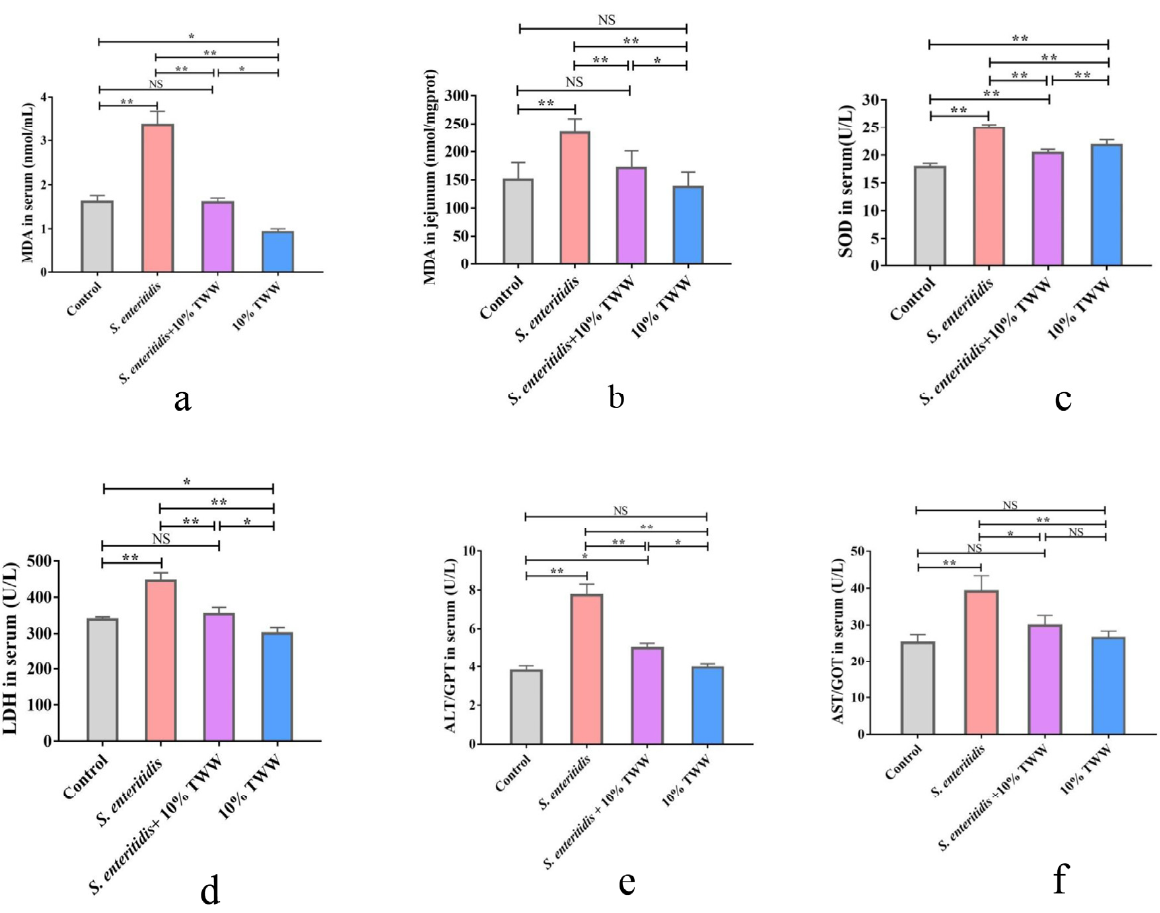
Figure 5. TWW ameliorates the oxidative stress index in S. enteritidis- infected chickens. ( a , b ) Malondialdehyde (MDA) content in serum and jejunum tissue. ( c ) Superoxide dismutase (SOD) activity in serum. ( d ) Lactic dehydrogenase activity in serum. ( e , f ) Alanine aminotransferase (ALT) and aspartate aminotransferase (AST) activity in serum. Values presented as means ± SEM. * p < 0.05, ** p < 0.01, compared between the indicated groups. NS: no significance between the indicated groups.